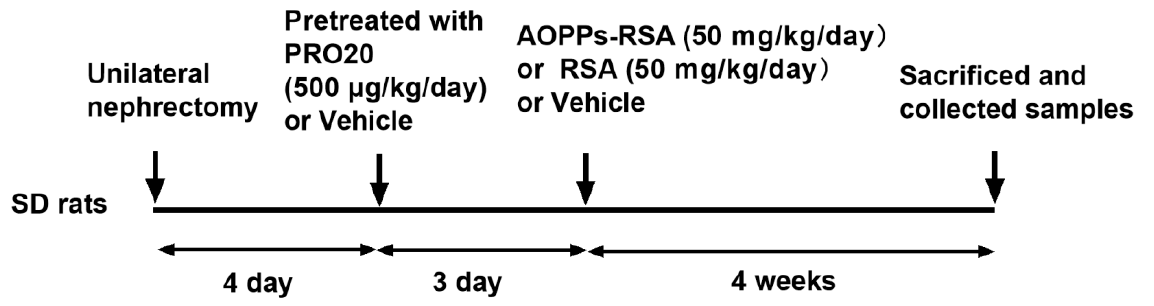
Figure 8. Graphical workflow of the experimental design. Notes: SD rats were administered CTR, RSA, AOPPs-RSA, or AOPPs-RSA in combination with PRO20; PRO20 was subcutaneously ad- ministered three times (7:00, 15:00, 23:00, respectively) every day. AOPPs-RSA or RSA were ad- ministered by tail vein injection once daily for 4 weeks. Administration of PRO20 started 3 days prior to administration of AOPPs-RSA or RSA. AOPPs: advanced oxidation protein products; RSA: rat serum albumin.